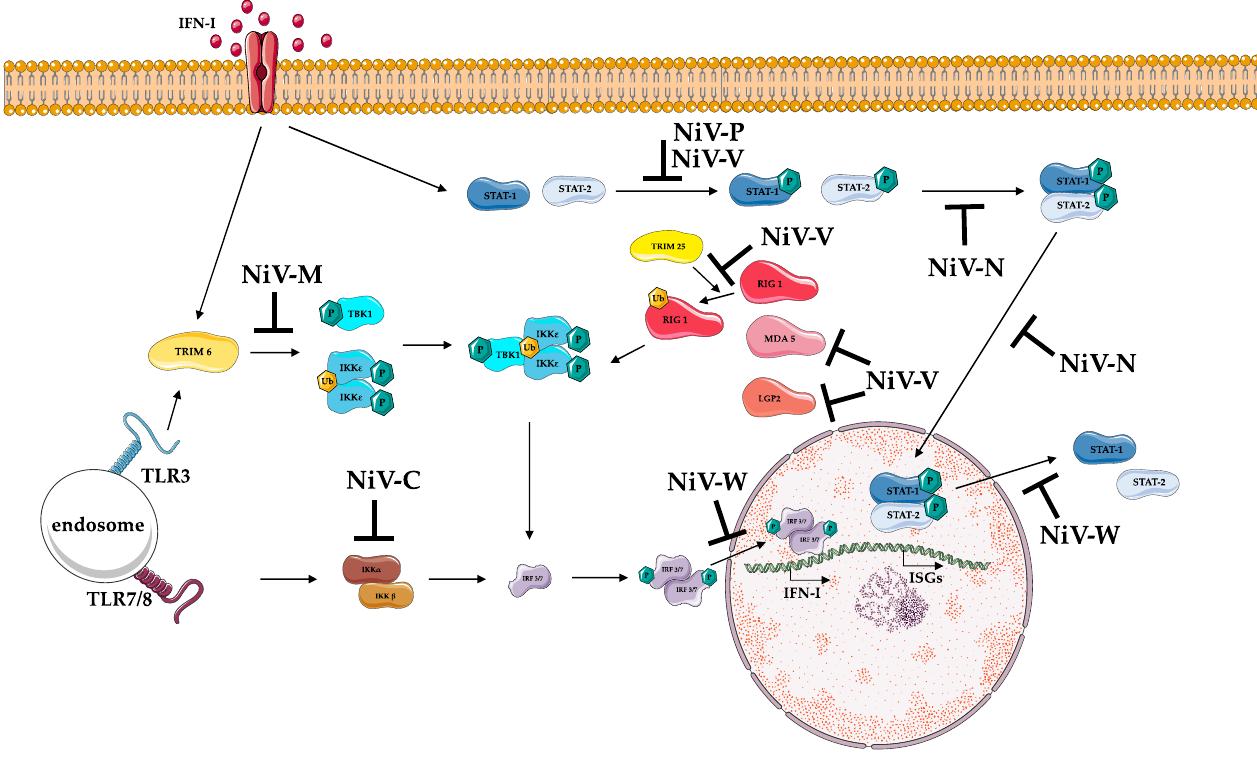
Figure 3. Schematic representation of NiV innate immune modulation in humans. NiV uses several immune modulation mechanisms to alter type I interferon (IFN-I) production and signaling. TLR and RLR detection of NiV RNA leads to IFN-I and IFN-stimulated gene (ISG) activation; however, several NiV proteins interfere in this process at different levels: NiV-V can prevent RIG-I, MDA5, and LGP2 stimulation. Conjointly with NiV P, NiV-V can also prevent STAT phosphorylation. NiV-N can inhibit STAT dimerization and also its nuclear importation. In addition, NiV-W prevents STAT1 and STAT2 nuclear exportation. NiV-M induces the degradation of TRIM6, thus preventing IKKε ubiquitination (Ub), oligomerization, and phosphorylation (P). NiV-C inhibits IKKα/β dimerization, necessary to activate IRF3 and IRF7, and in the same pathway, NiV-W protein inhibits nuclear transport of phosphorylated IRF3/7 dimers. Altogether, these mechanisms prevent the expression of IFN-I and ISG genes.